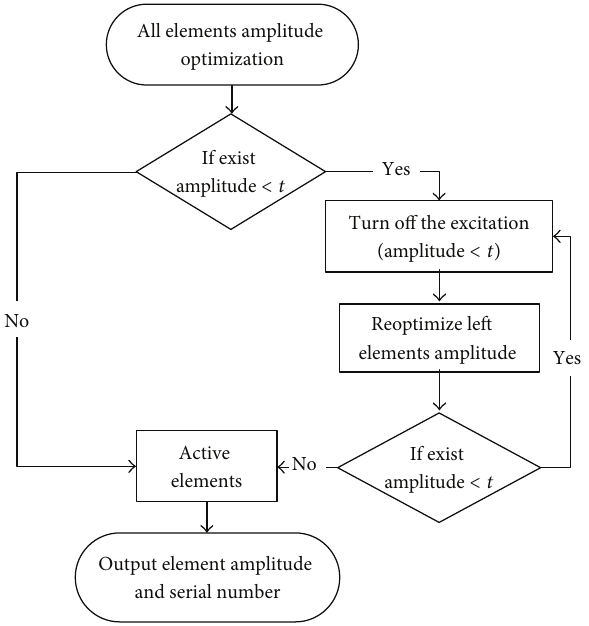
Figure 11: Element selection strategy.